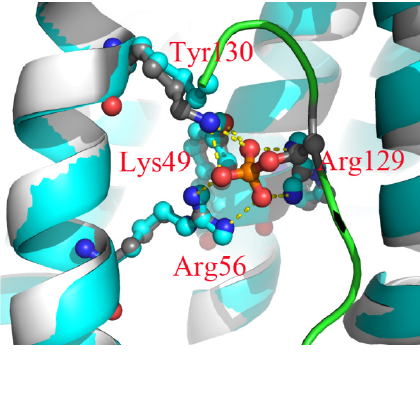
Figure 1. Superimposed structures of 1YWT (white) and 1YZ5 (cyan). The proteins are